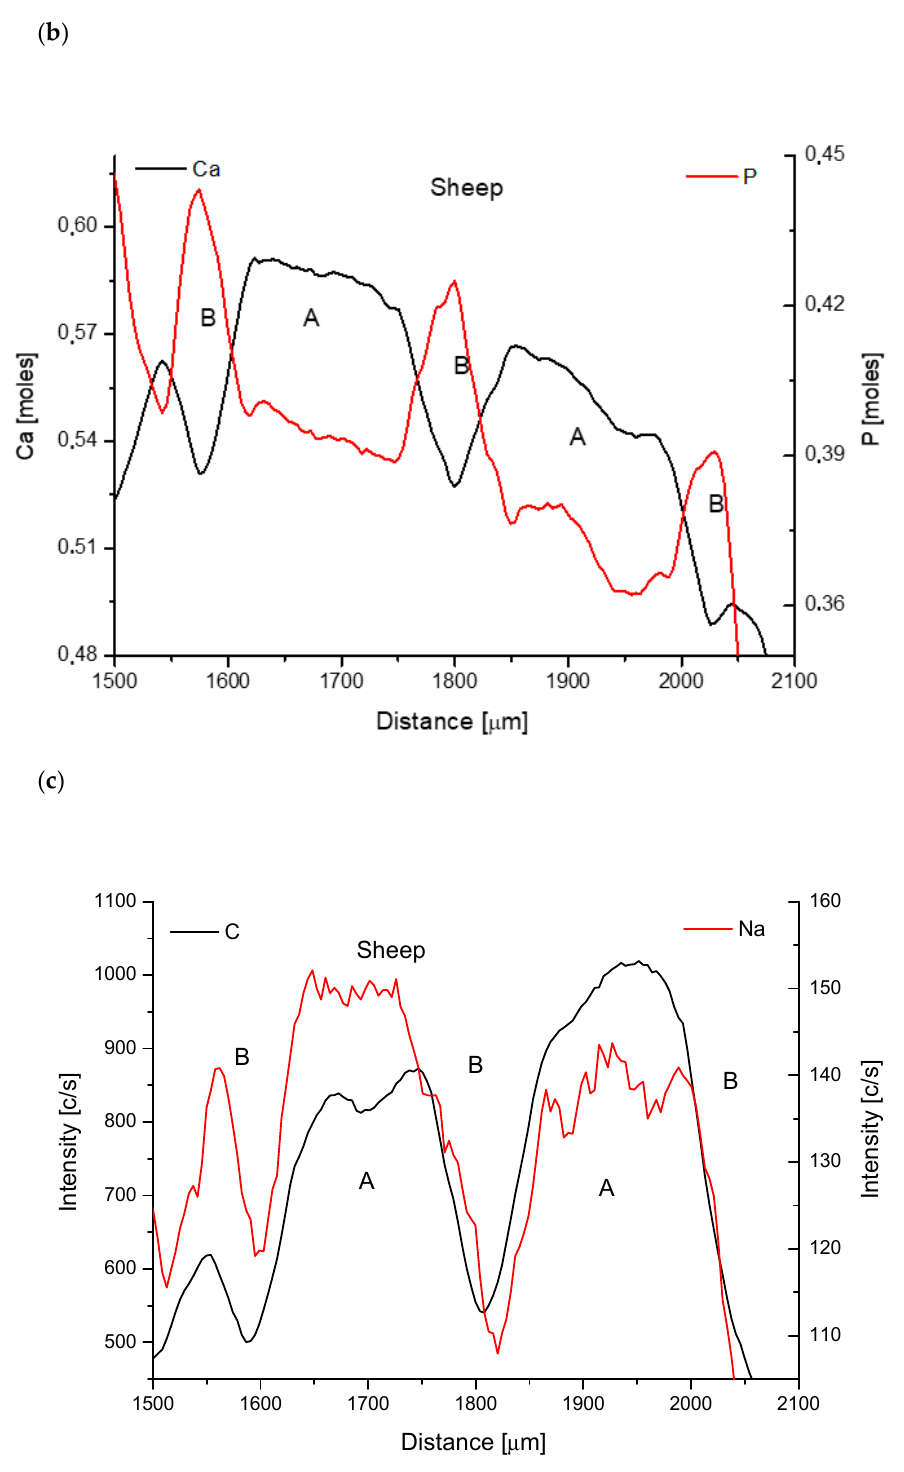
Figure 4. Secondary oscillations of elements in sheep dentin, shown in the pairs: ( a ) Mg-C; ( b ) Ca-P; ( c ) C-Na. Letters a and b’ denote the kind of peculiar apatite in given zone.